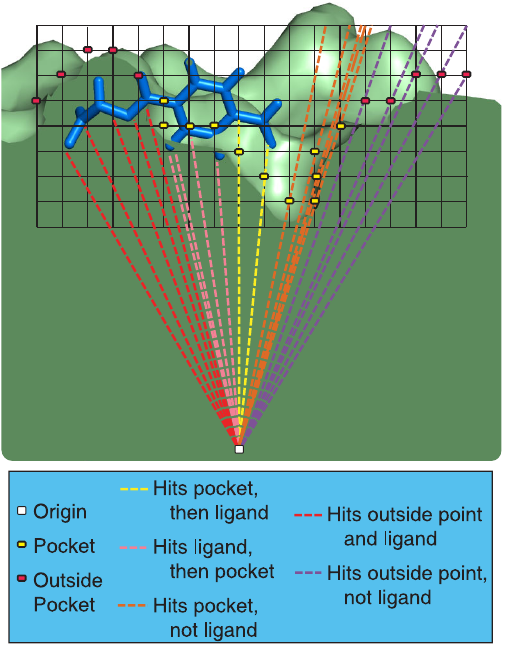
Figure 2. Docking approach using ray casting. A schematic diagram of DARC scoring is shown in cross section. A grid is placed at a region of interest on a protein surface, and used to identify ‘‘deep pocket’’ points. Points that are not in direct contact with the protein surface are removed, leaving behind a set of points that map the topography of the protein surface pocket ( yellow squares ). An adjacent layer of points on the protein surface are then labeled ‘‘forbidden’’ points ( red squares ). Rays are cast from an origin point within the protein ( white square ) at each pocket point and forbidden point. To score a docked pose, the same rays are cast at the ligand ( blue ), and the first intersection (if any) is calculated. The contribution to the total score from each ray is dependent on whether the ray was defined based on a pocket point or a forbidden point, and whether the ray intersects this point before or after it intersects with the ligand. These conditions are described in detail in the main text.